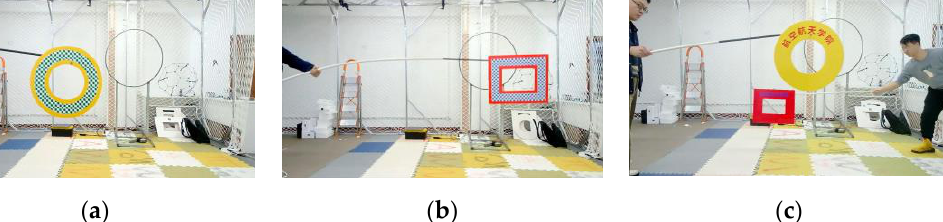
Figure 2. Samples in benchmark for object tracking with motion parameters. ( a ) Circular-like sample, ( b ) rectangle-like sample, ( c ) monochrome samples for classification.